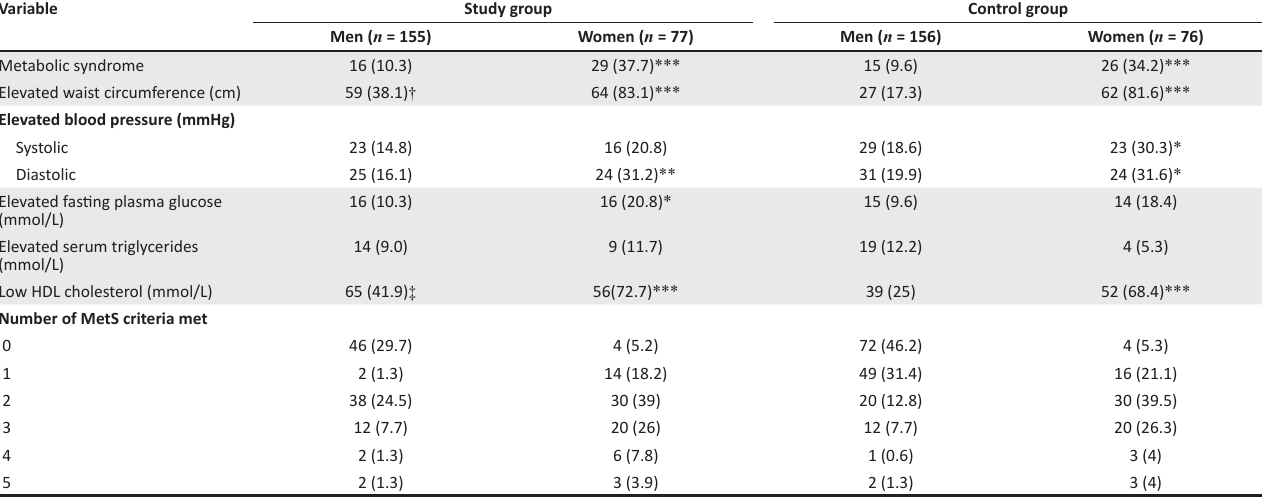
TABLE 2: Prevalence of metabolic syndrome and individual components in the study ( n = 232) and control group ( n = 232). Variable